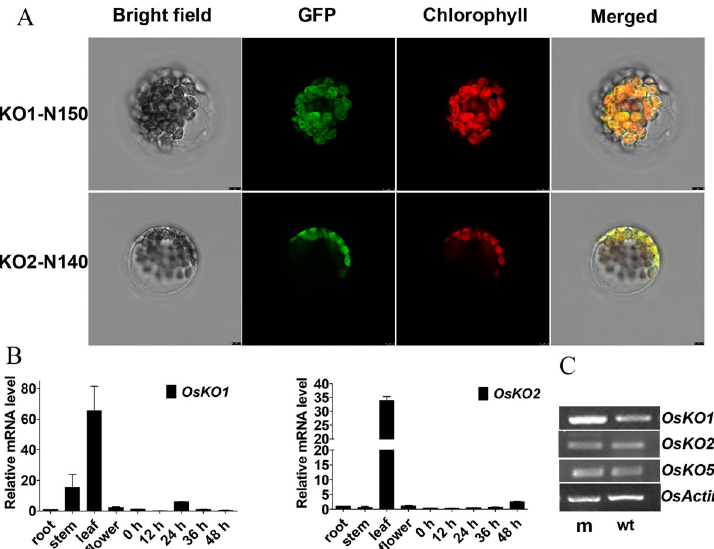
Fig 5. Subcellular localization of OsKO1 and OsKO2, and expression analyses on their encoding genes. (A) Subcellular localization of OsKO1 and OsKO2. OsKO1-N150 and OsKO2-N140 indicates the N-terminal 150 and 140 amino acids of OsKO1 and OsKO2, respectively. The N-terminal regions containing transit peptides of OsKO1 and OsKO2 were fused to GFP, and transiently expressed in Arabidopsis mesophyll protoplasts, respectively. Scale bars = 2.5 μ m. (B) Expressional patterns of OsKO1 and OsKO2 . Rice OsActin1 was used as internal reference for the qRT-PCR analysis. Data are means ± SE (n = 3). The 0, 12, 24, 36 and 48 h stand for the embryos from the rice seeds at different time after imbibition, respectively. (C) Comparison of the expressional levels of OsKO1 , OsKO2 and OsKO5 in the rice seed at 24 after imbibition between mutant and wild-type.